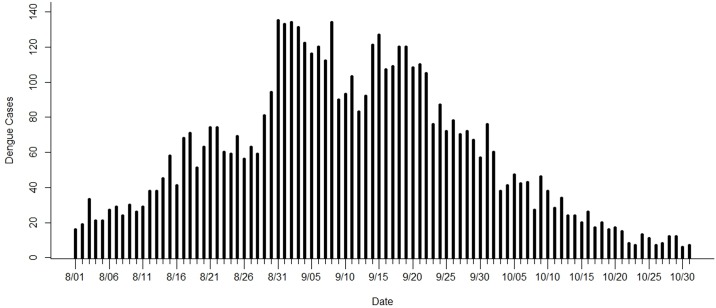
Daily dengue incidence data for North District, Tainan city, Taiwan, from August to October, 2015.